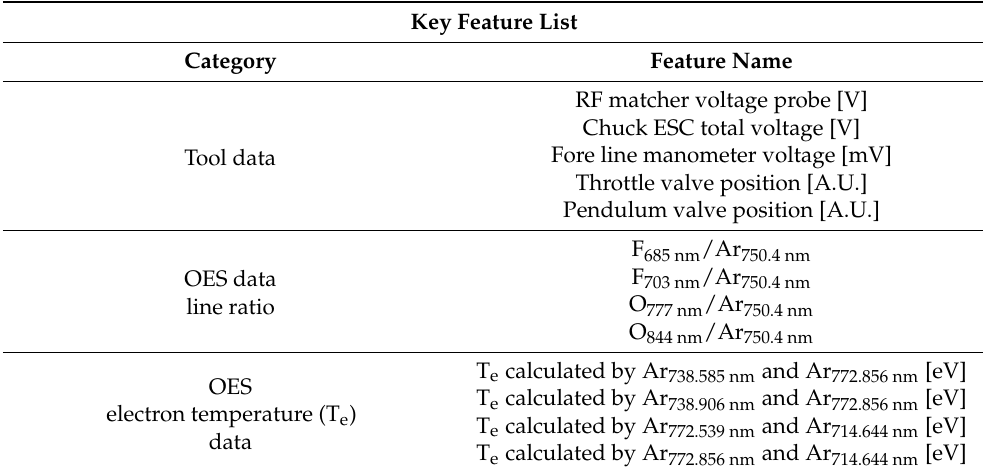
Table 6. Selected key feature